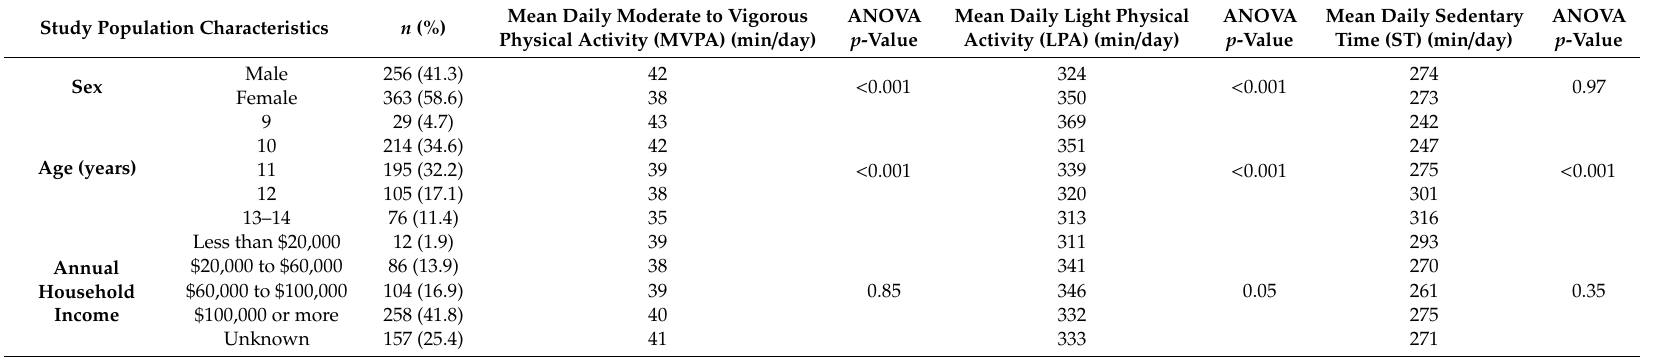
Table 1. Study population characteristics of those contributing valid accelerometer data ( n = 619).